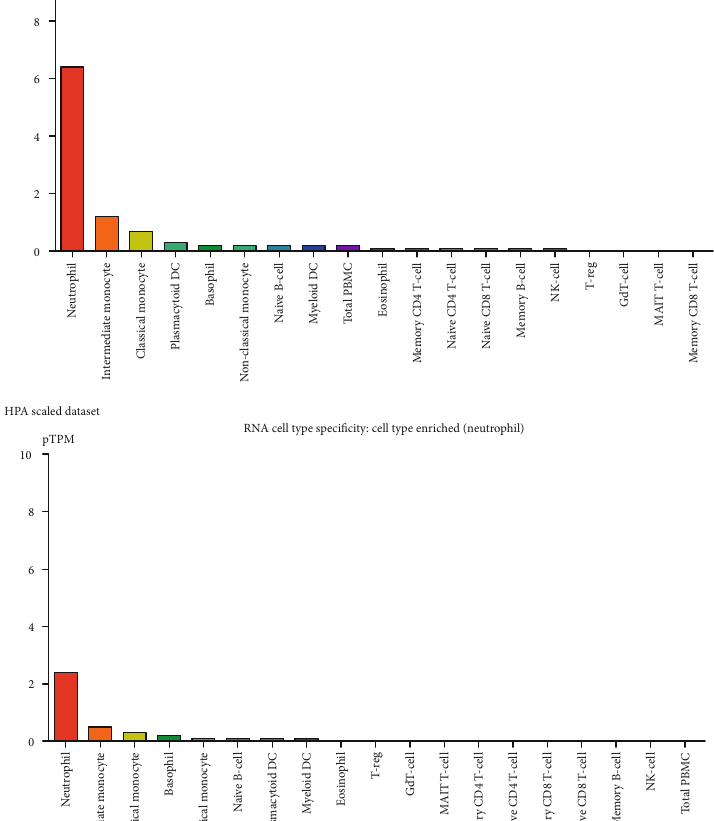
RNA cell type specificity: cell type enriched (neutrophil)